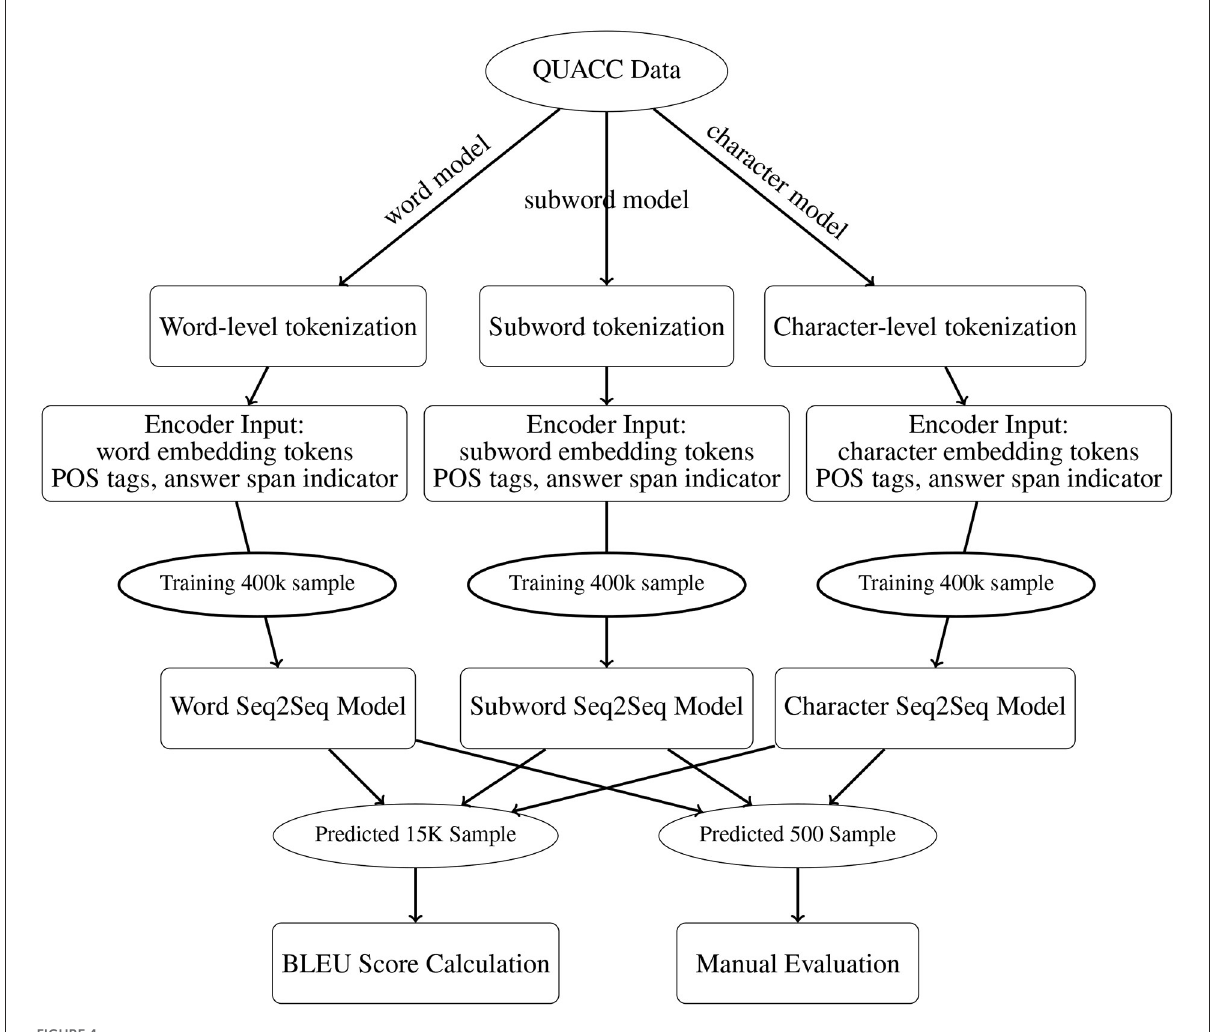
FIGURE4 Question generation and evaluation